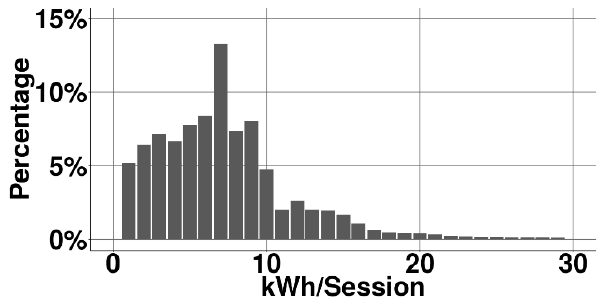
Figure 5. Distribution of kWh charged at level 2 charging stations.